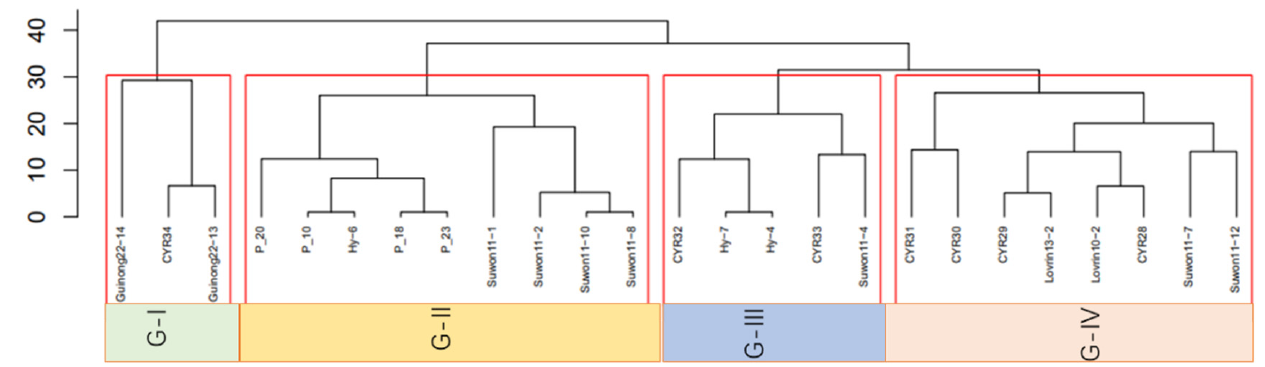
lines JubilejinaII, Kangyin 655 Zhong 4, T. spelta var. Album, Guinong22 were shown to be resistant to these races. These groups of races were not specific to one region, although race frequencies varied from region to region.